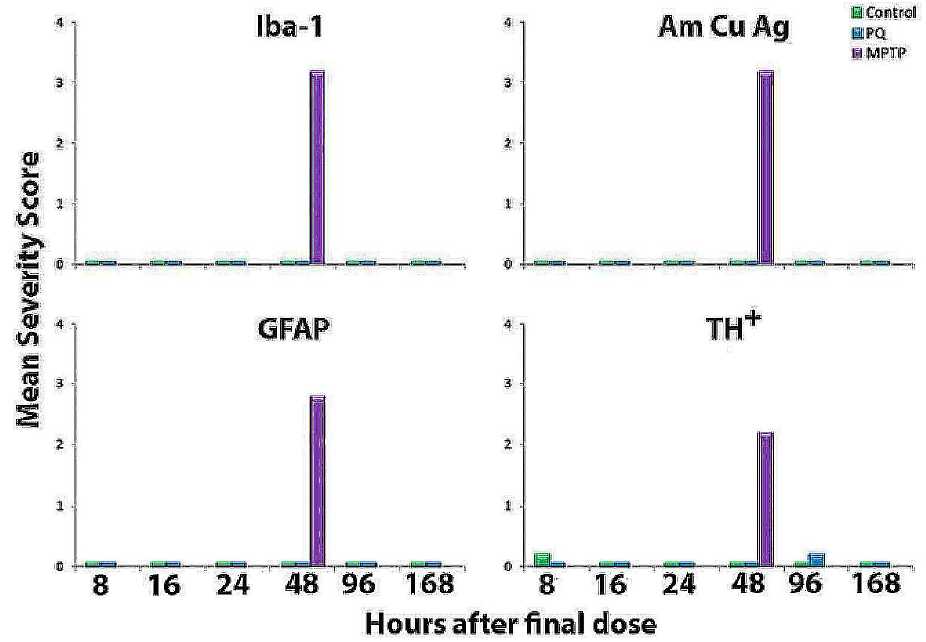
Fig 7. Mean histopathological severity scores in control, paraquat and MPTP-treated groups of C57BL/6J male mice. Mice were 16 weeks of age at the time of treatment initiation. Mice were administered 10 mg/kg/dose PQ (cid:1) Cl 2 by ip injection,twice a week for 3 weeks and were sacrificed 8, 16, 24, 48, 96 or 168 hours after the last dose. Control mice were given the vehicle while MPTP-treated mice received four injectionsof MPTP (16 mg/kg/dose; expressed as free base) at 2-hour intervals, and then euthanized 48 hours after the final dose. Serial sections through the SNpc were evaluated qualitatively and the group mean severity grades are plotted. Grades 0 to 5 reflect increasingintensity of staining for Iba-1, AmCuGg, GFAP and decreasedstaining intensity of TH.